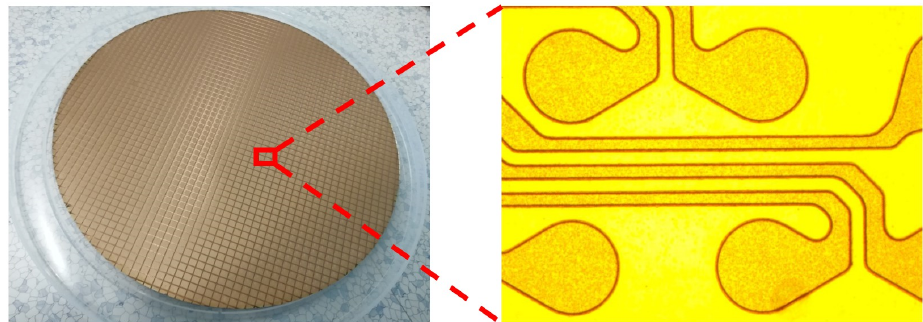
Figure 16. The outlook of the wafer after electroless-plating Ni/Au.